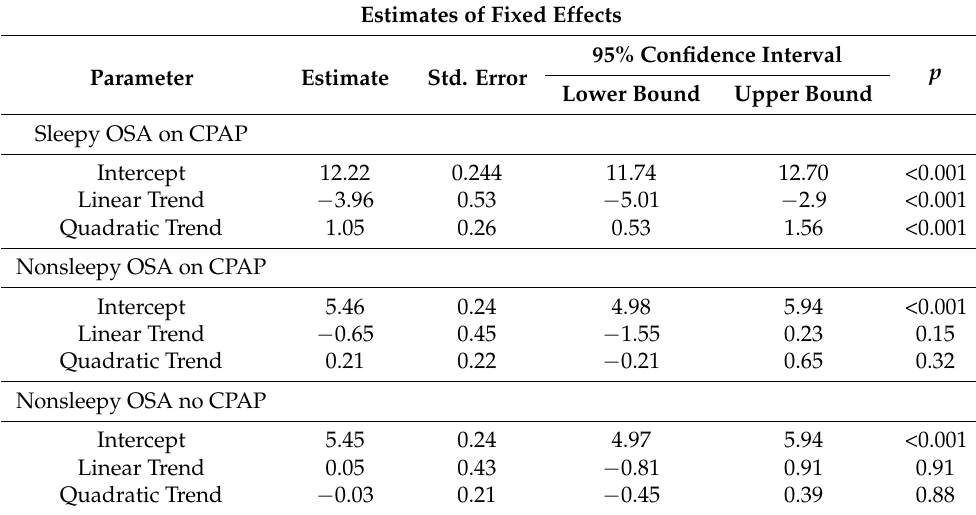
Table 4. The fixed effect of the “time” as linear and quadratic trends in the model.